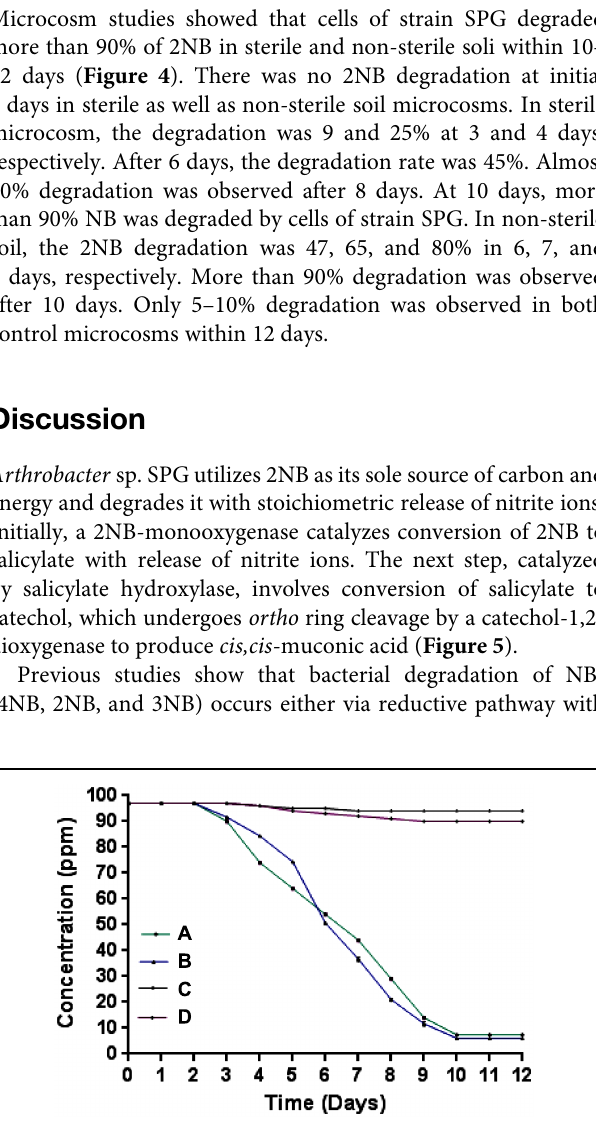
FIGURE 4 | Microcosm studies. (A) Sterile soil microcosm with inoculated bacteria; (B) non-sterile soil microcosm with inoculated bacteria; (C) control sterile microcosm without bacterial inoculation, and (D) control non-sterile microcosm without bacterial inoculation.